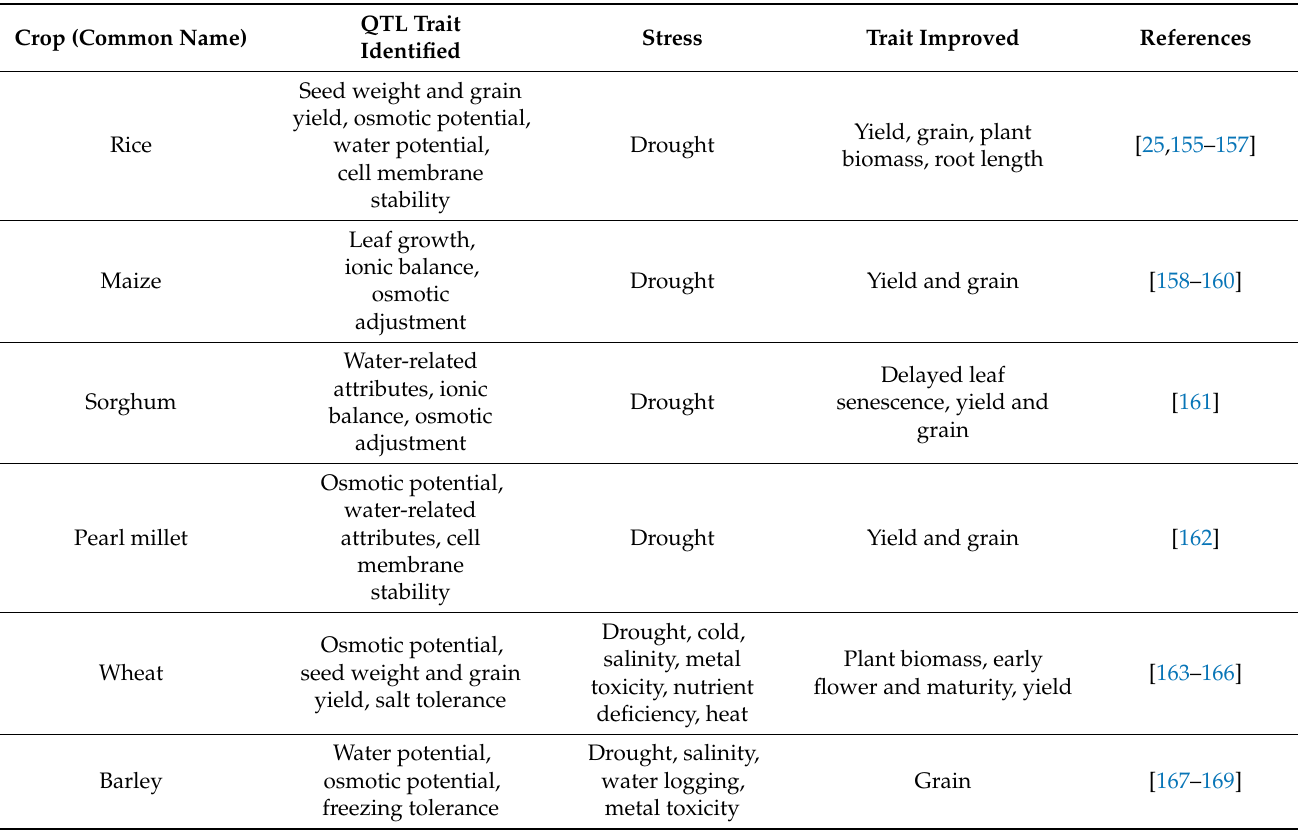
Table 2. QTL identified in different cereal crops for abiotic stress-related